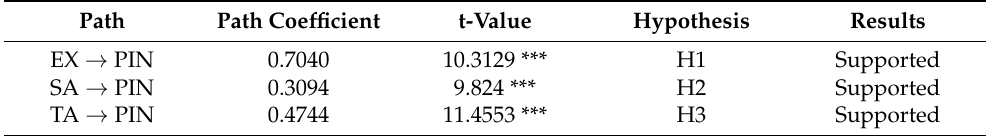
Table 5. Path coefficients of the model.